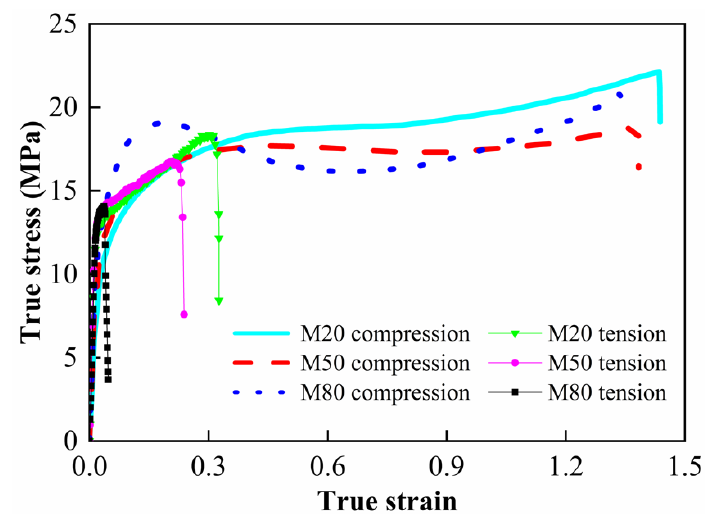
Table 2. Characteristic parameters of the Al-PTFE-W materials under quasi-static condition.